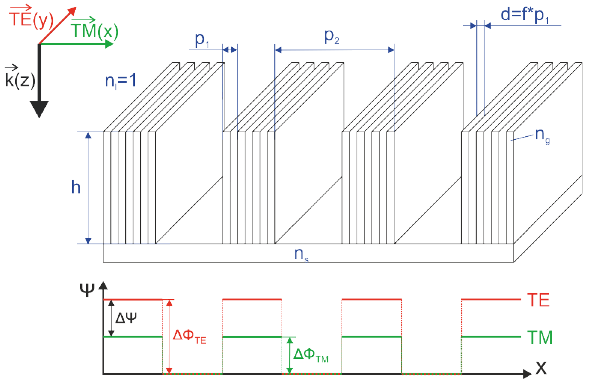
Figure 1. Design